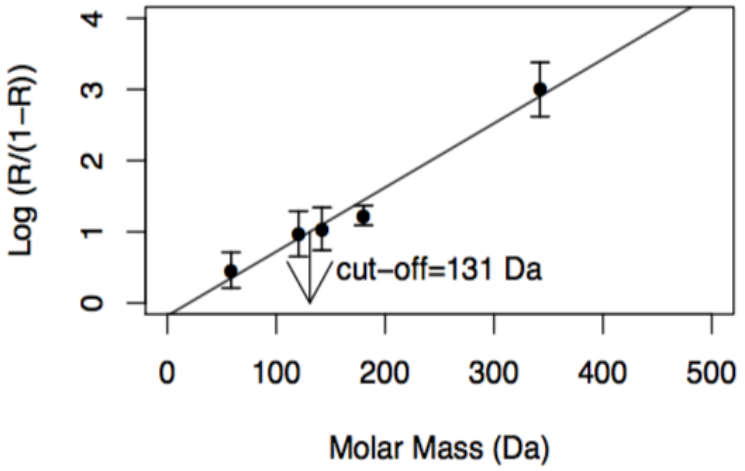
Figure 2. Experimental determination of molecular weight cutoff (MWCO) of NF membranes at a transmembrane pressure of 1.0 × 10 6 Pa, v = 0.94 m · s − 1 and concentrations of reference solutes of 2.0 kg m − 3 . Table 3. Determination of hydraulic permeability and cutoff of nanofiltration (NF) membranes. Regression Lines (with 95% CI for the Parameters